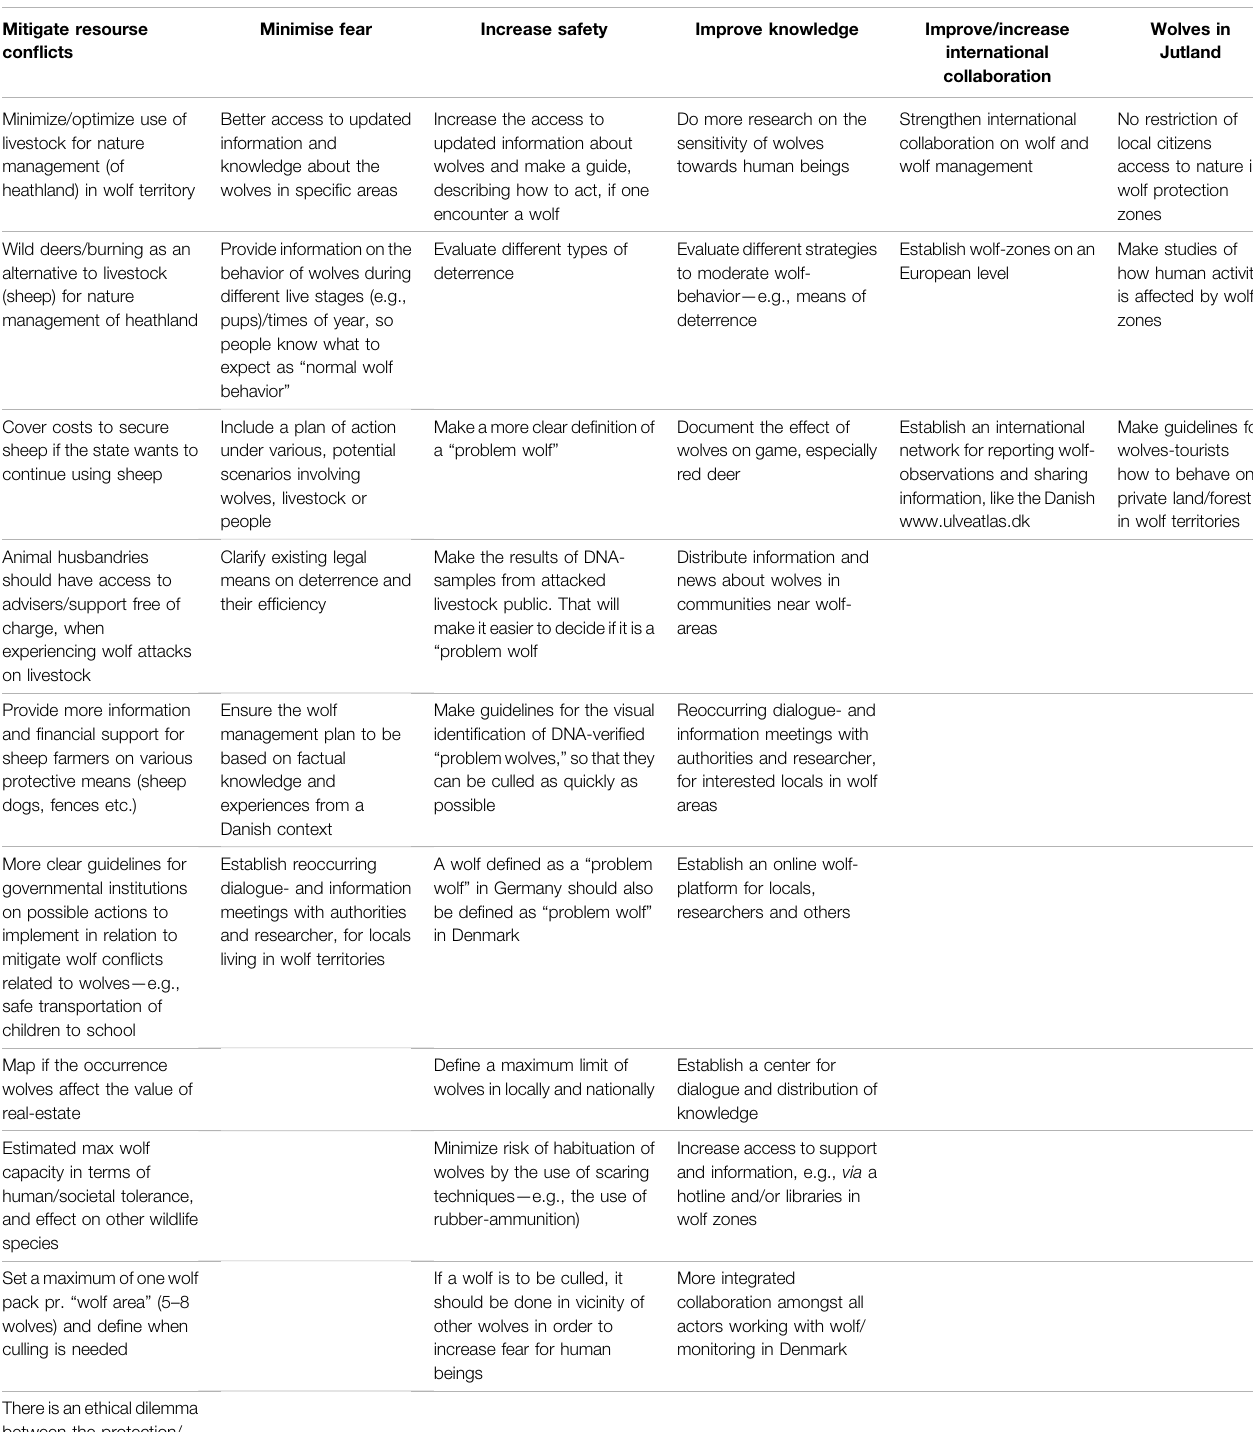
TABLE 5 | An overview of input from the participants WDP to the expected new national wolf